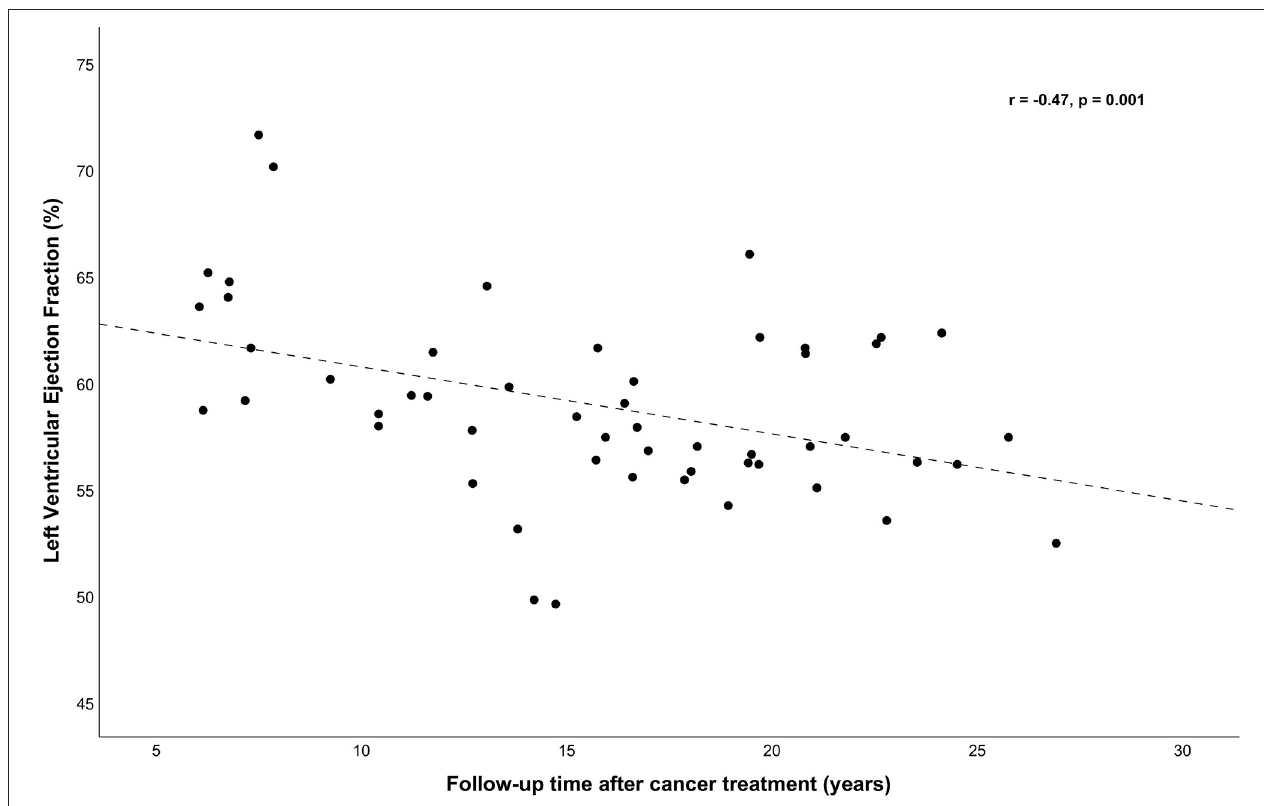
FIGURE 1 | Left ventricular ejection fraction (LVEF, %) was correlated (adjusted for sex and age) with follow-up time ( r = − 0.47, p = 0.001). With simple linear regression a significant regression equation was found [ F (1,51) = 10.65, p = 0.002], with an r 2 = 0.173. The predicted LVEF (%) was 63.86–0.315 (years of follow-up time after cancer treatment).